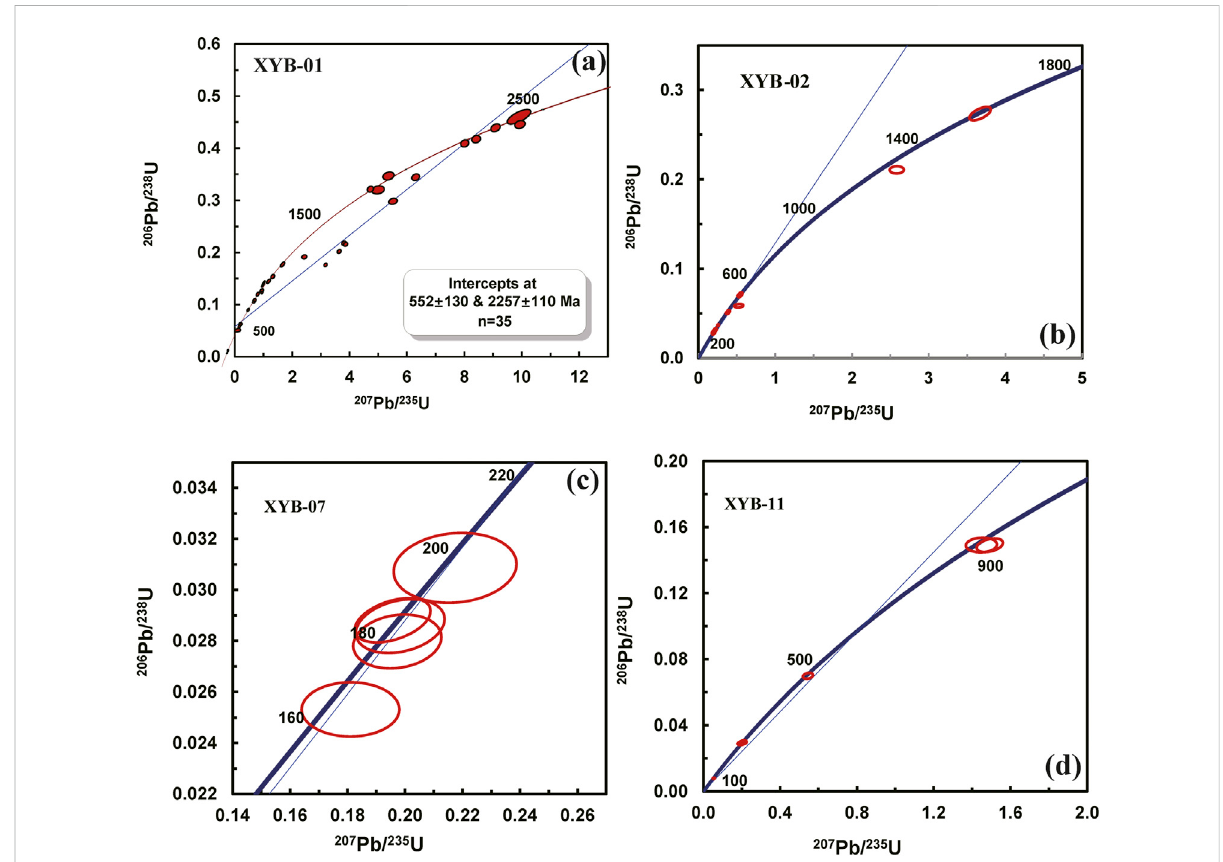
FIGURE 9 U-Pb age concordance of zircons of amphibolite for (A) XYB-01; (B) XYB-02; (C) XYB-07; (D) XYB-11.